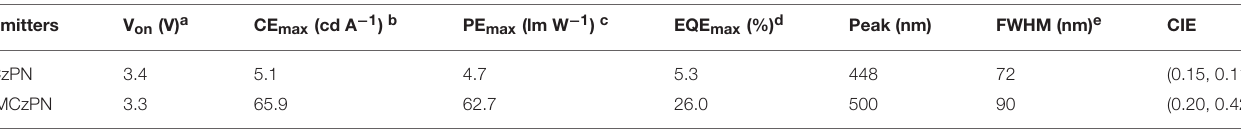
TABLE 2 | Electroluminescence properties of the